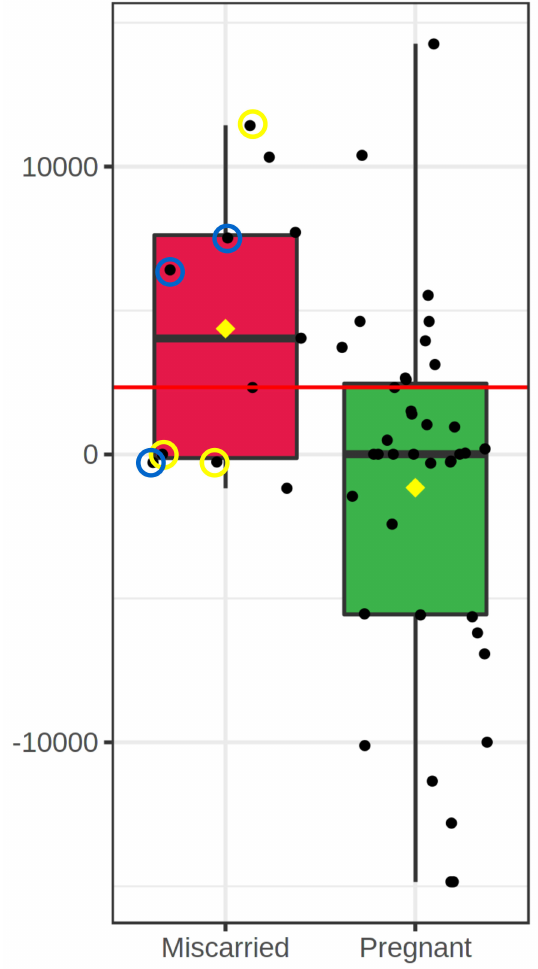
Figure 6. Boxplot for Methyl adipate concentrations that differ between embryos that miscarried after Day-40 and embryos that led to pregnancy on Day-40. Circled samples indicate fresh embryos cultured in BSA (yellow line), and frozen embryos cultured with FCS (blue line); non-circled samples are frozen embryos cultured with BSA (no miscarried samples from fresh embryos cultured with